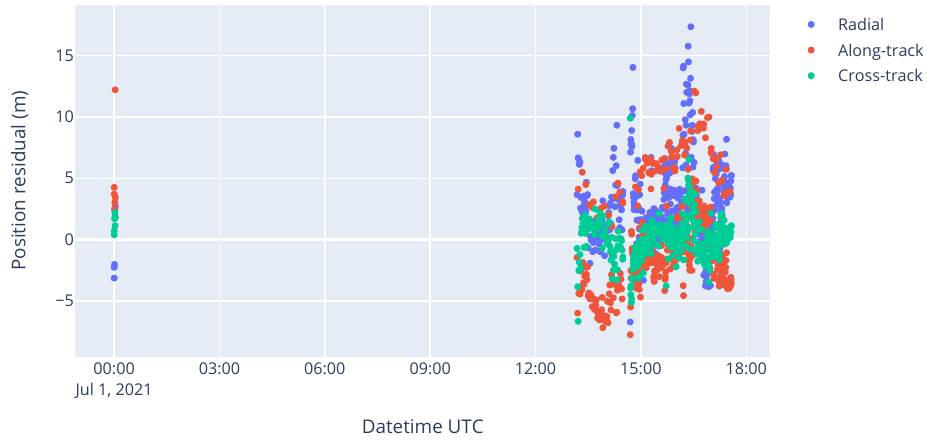
Figure 4. Position residuals (GPS data minus estimated orbit) in LVLH frame from the second orbit determination